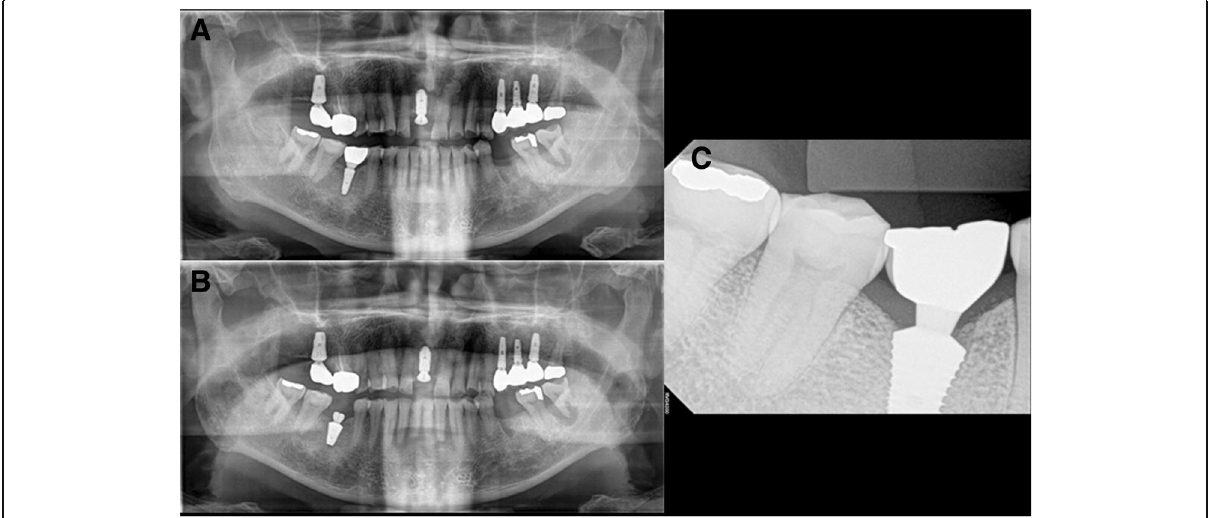
Fig. 5 M3, radiographs a #46i second failure, preoperative panoramic radiograph, b #46i, third installation, c #46i, prosthesis